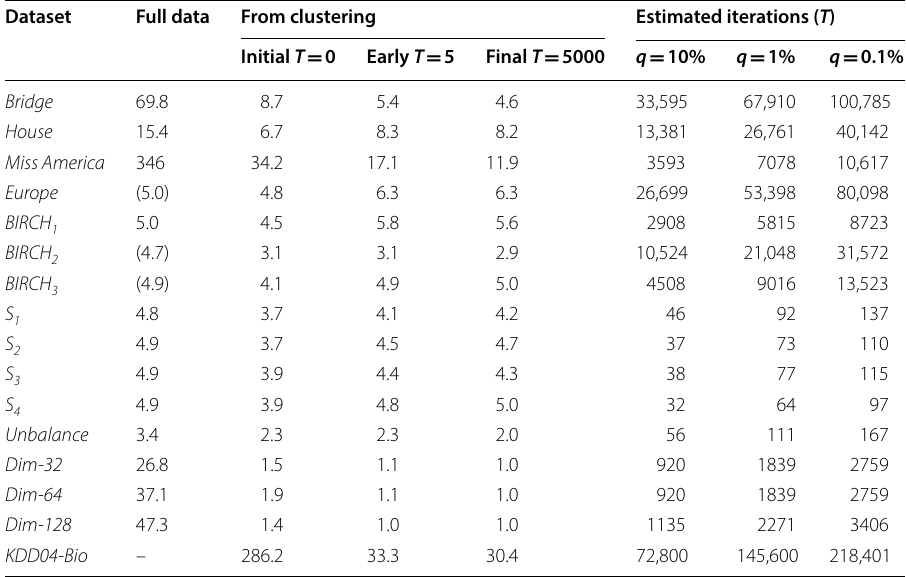
Table 3 Neighborhood size ( α ) estimated from the data and from the clustering result after T